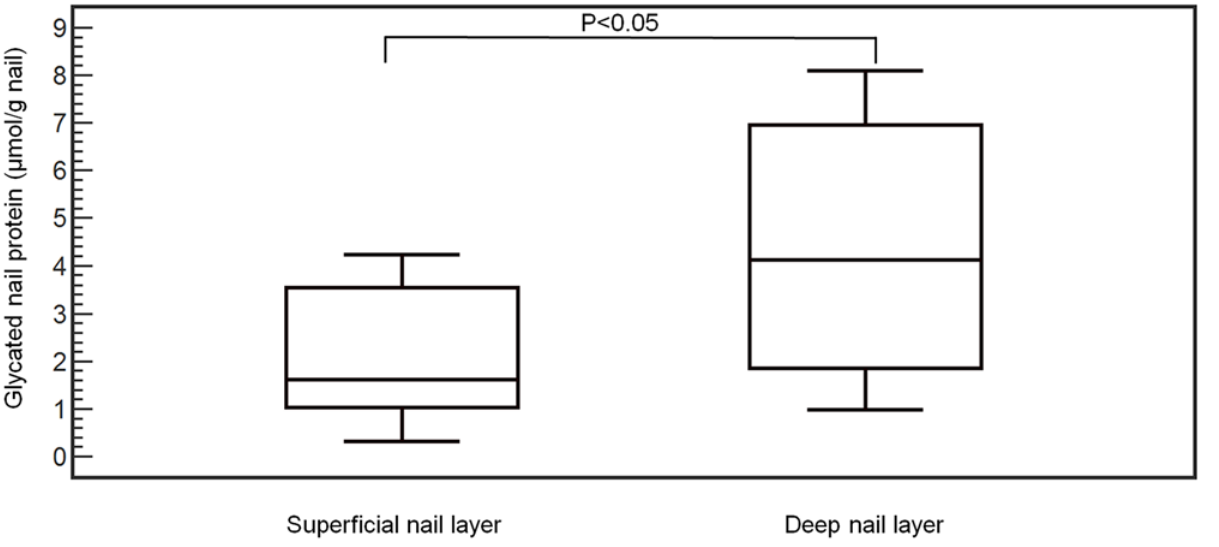
Fig 2. Glycated nail protein concentration between deep and superficial layers of the human finger nail (n =